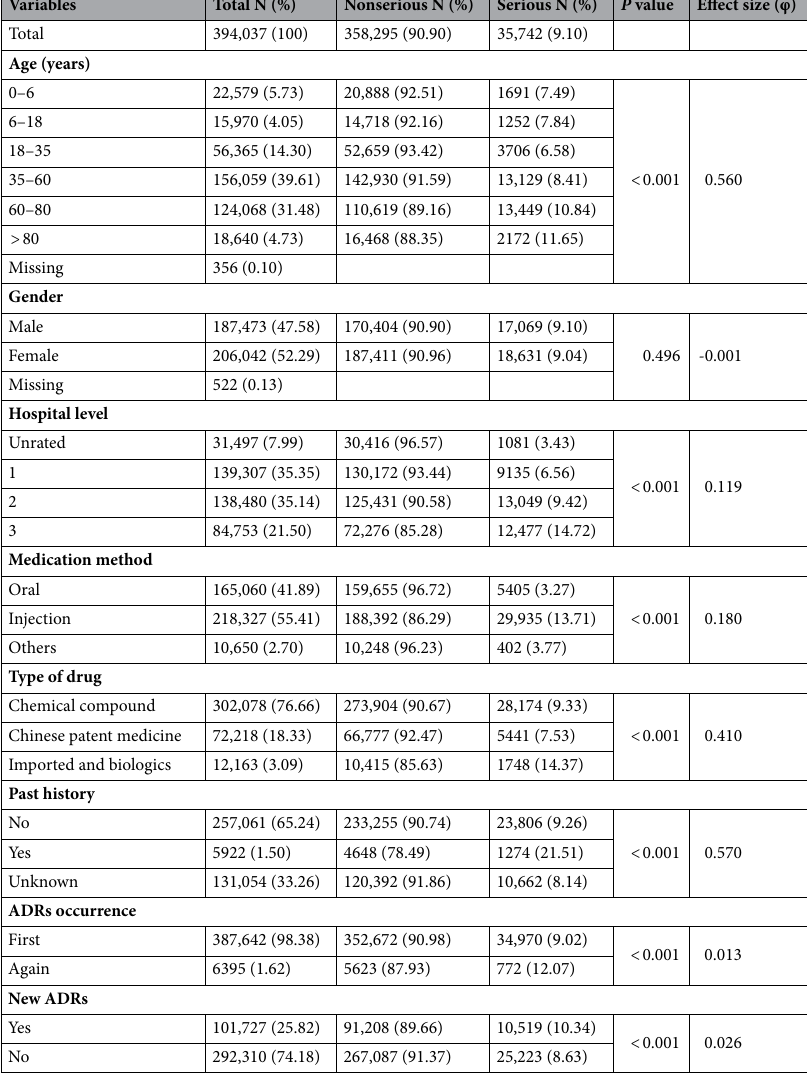
Table 1. The severity of adverse drug reactions was different in patients with different characteristic.